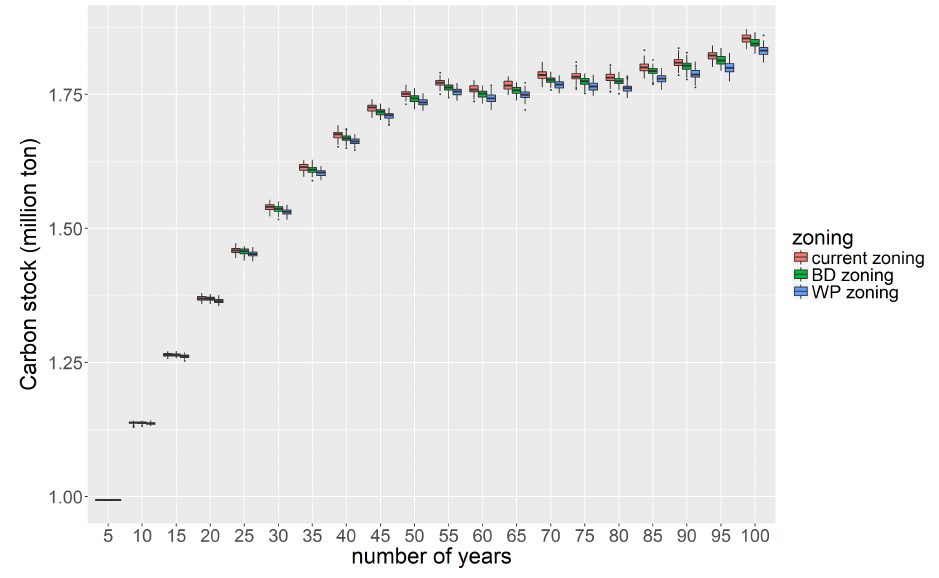
Figure 10. Change of carbon stock simulated with the DSA. Boxes show median values, maximum and minimum values, and quartiles of each